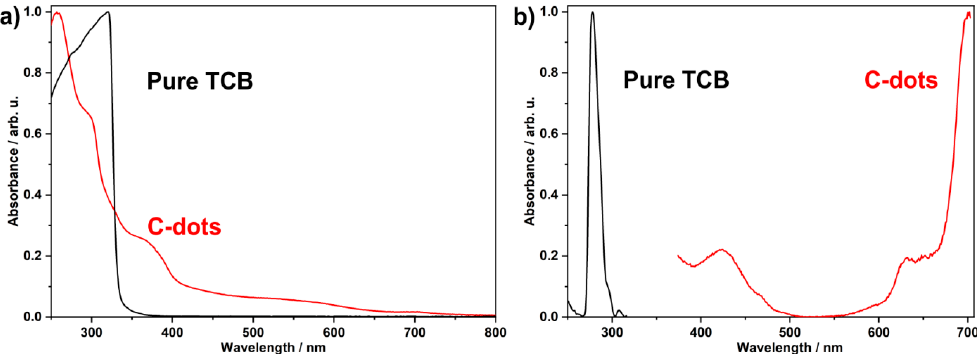
Figure 5. Absorption of the as-prepared C-dots: ( a ) UV–Vis spectra and ( b ) excitation spectra (suspension in PEG400, monitored at λ em = 715 nm, excitation of the C-dots could not be measured below 370 nm due to λ em / 2 peak at 357 nm). Pure TCB is shown as a reference (solution in chloroform, monitored at λ em = 332 nm).